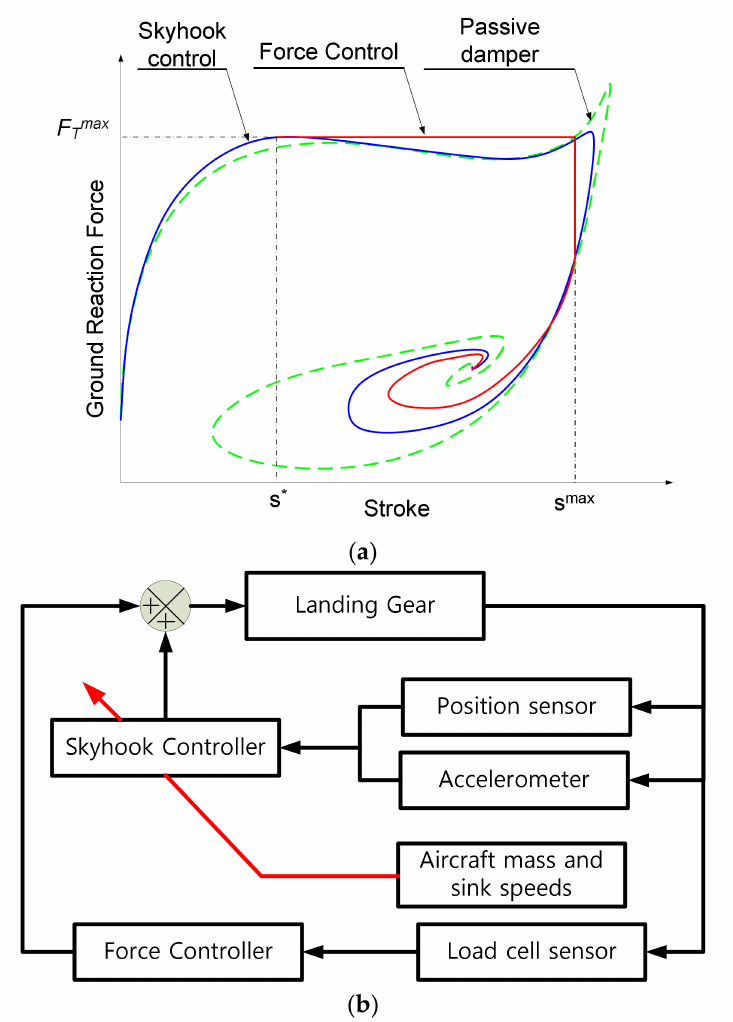
Figure 6. ( a ) Principles of hybrid controller, ( b ) hybrid control block. Hybrid controller with a load cell sensor and known aircraft mass